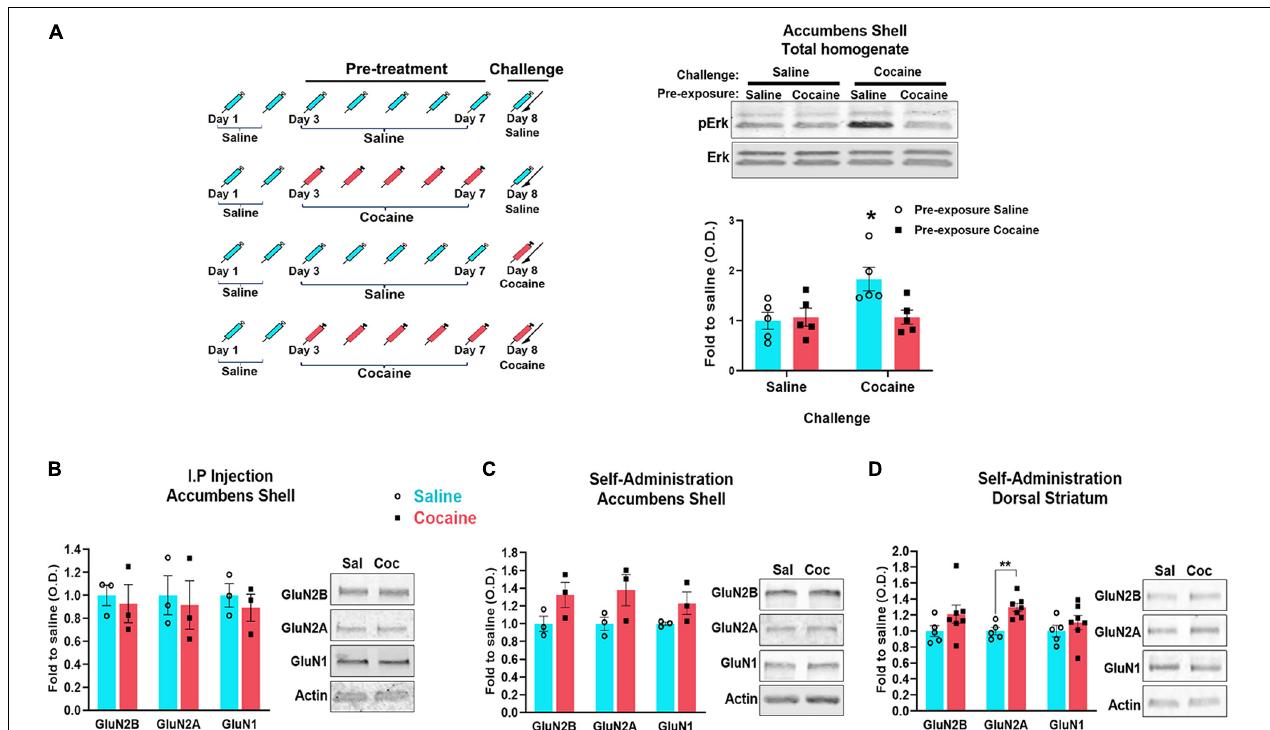
FIGURE 4 | Timeline of the experiments: mice were i.p. injected 5 days with saline or cocaine (Pre-treatment) ( A left ). 24 h after the last injection, half of animals previously injected with cocaine were injected with an additional cocaine (challenge) and half with saline. Half of animals previously injected with saline were injected for the first time with cocaine (challenge) and half with an additional saline. 20 min after the last injection, the accumbens shell was dissected and the phosphorylation of ERK (pERK) was analyzed by western blot (1 animal/sample, n = 5 samples/group) ( A right ). Tissue was dissected 1 month after the last cocaine exposure. PSD enriched fraction was isolated and analyzed by western blot to detect the indicated proteins (B–D) . For accumbens shell (B,C) : n = 3 samples/group, 4 mice/sample. For dorsal striatum (D) : n = 5 samples/group, 1 mouse/sample (control group), and n = 7 samples/group, 1 mouse/sample (cocaine group). Data are represented as mean ± SEM. * p < 0.05, ** p <